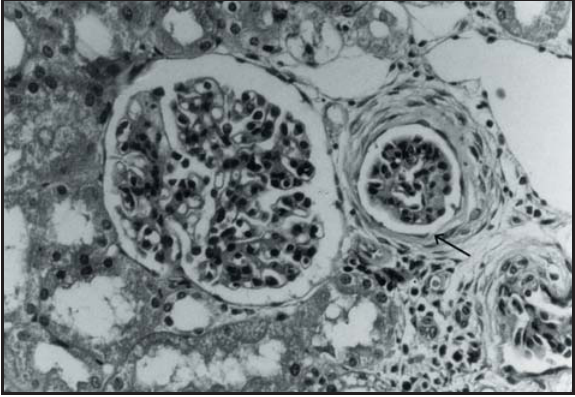
Figura 3 – Proliferação mesangial difusa: glomérulo com hipercelularidade. Presença de microglomérulo ( (cid:110) ) (caso 5, HE, 160x)